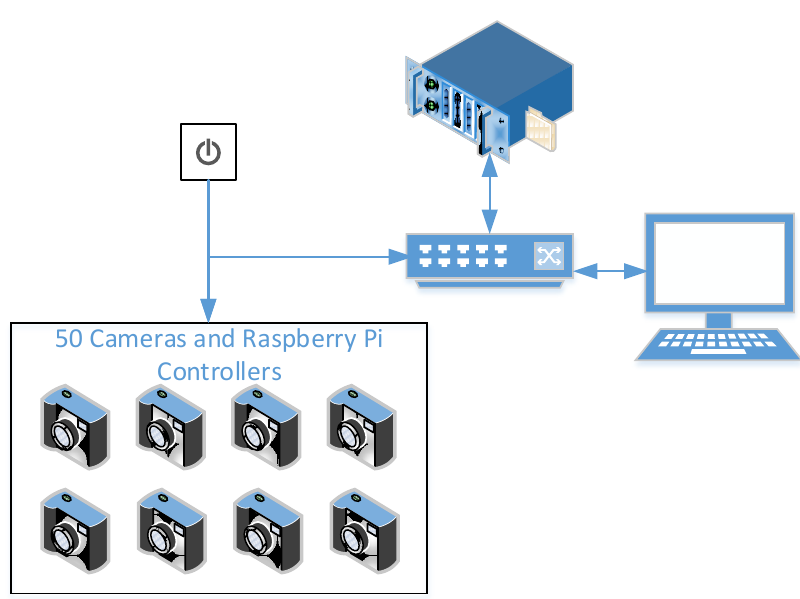
Figure 4. System electronics